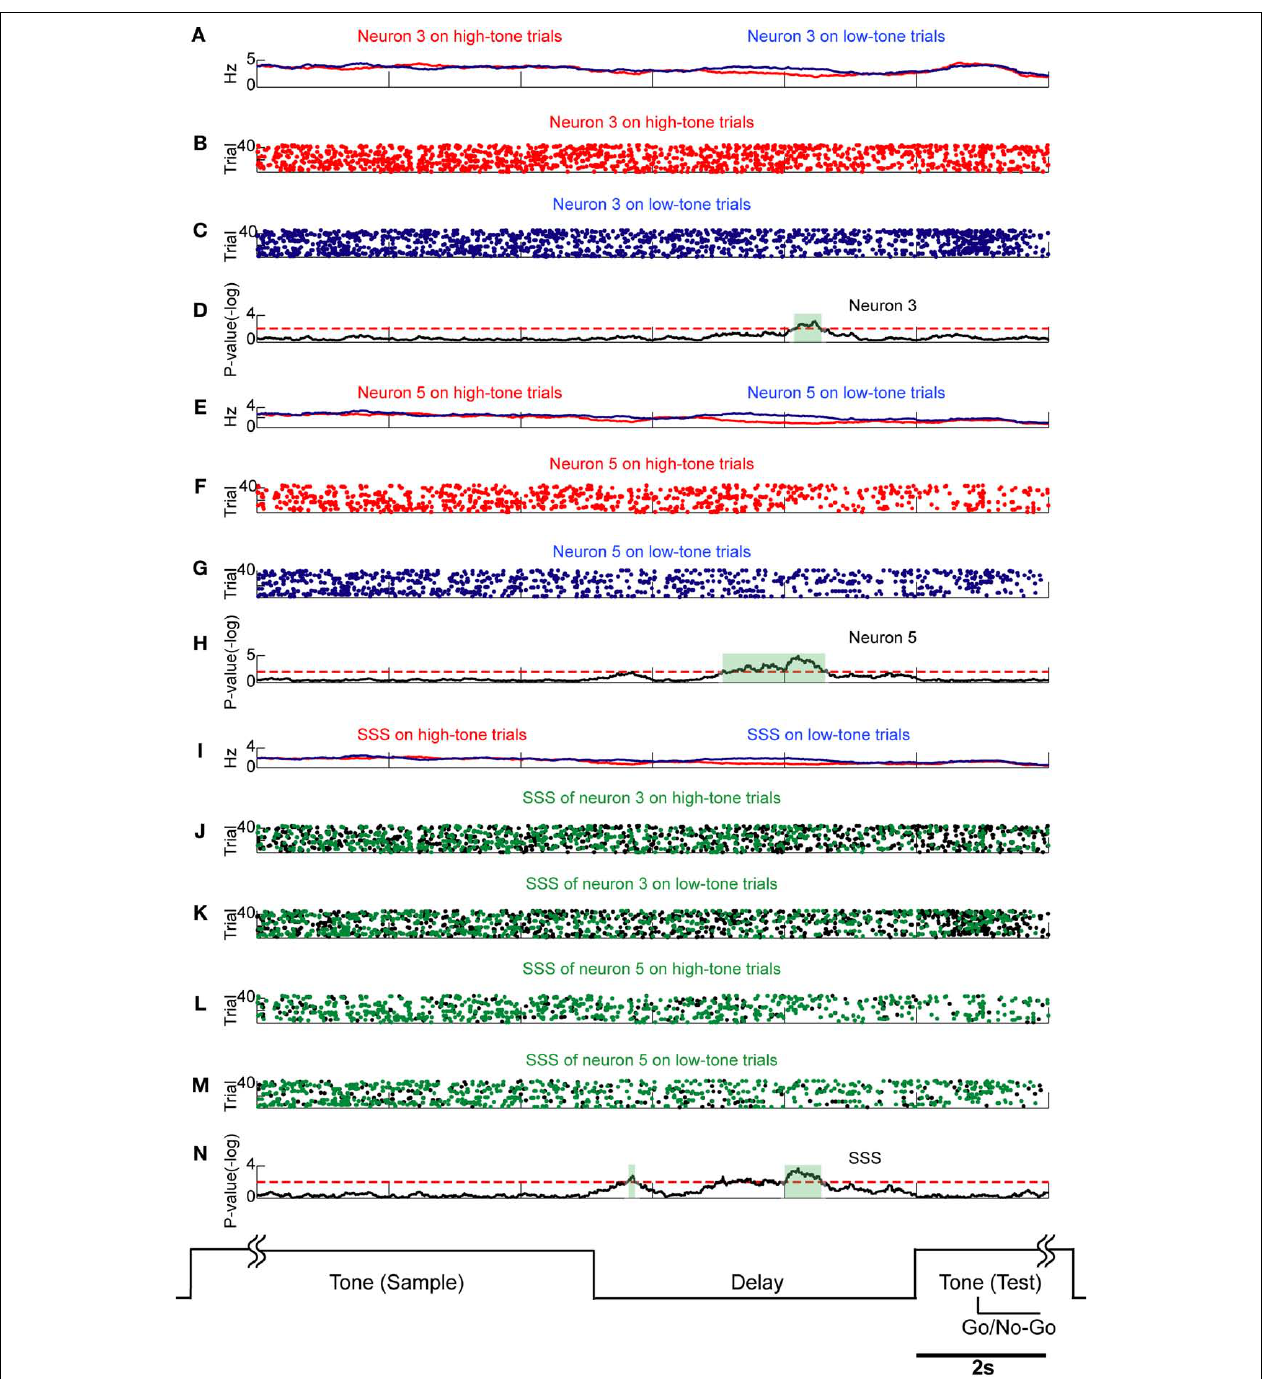
FIGURE 6 | SSSs related to retention of the stimulus are associated with fi ring rate modulations. Comparison of SSSs and rate modulations between high tone and low tone trials was selected in this example. Each subfi gure averages all correct trials of a session. Results of U -tests of 5 s of tone presentation in the preceding trial, 5 s of delay, and 2 s of tone presentation in the next trial are shown. (A) Firing rates of neuron 3 in high tone (red) and low tone (blue) trials. (B,C) Raster plots of spikes of neuron 3 in high tone (red) and low tone (blue) trials. (D) The